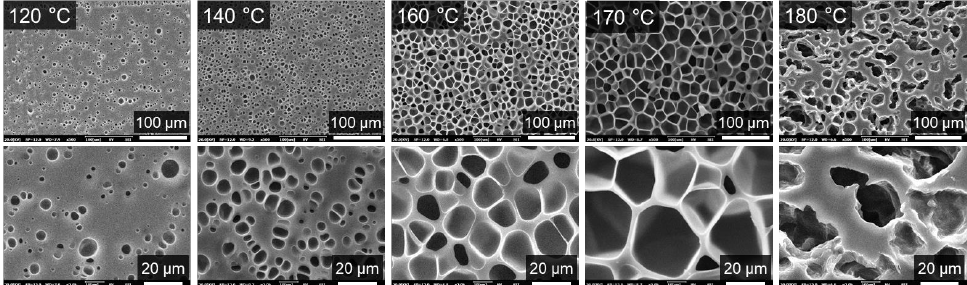
Figure 5. SEM images of cell morphology in HD-TPU foams prepared at different saturation tem- peratures. The bottom row of the image is a partial enlargement of the top row.